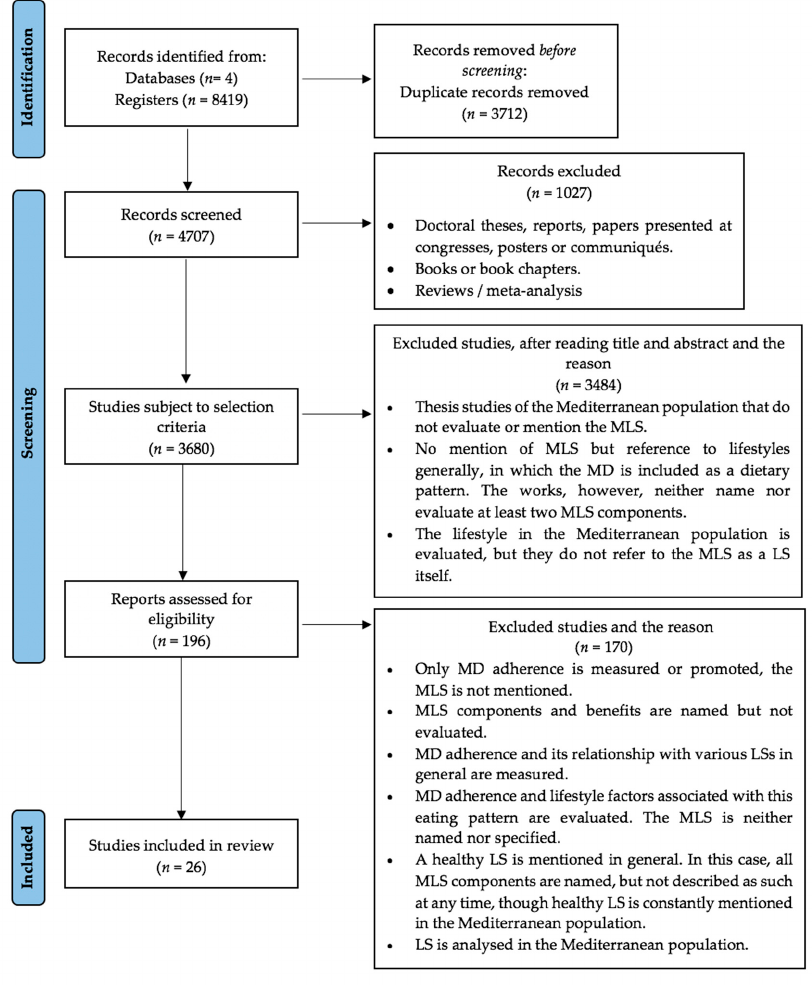
Figure 1. PRISMA flow diagram of studies evaluated in the systematic review.